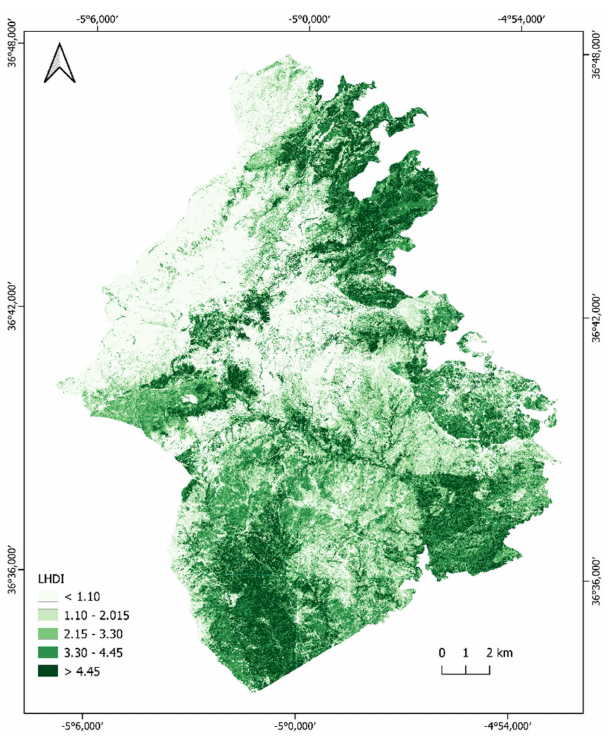
Figure 5. LiDAR Height Diversity Index (LHDI) of forest types in Sierra de las Nieves National Park (M á laga, southern Spain). Table 3. Biomass, LiDAR Height Diversity Index (LHDI), and Fuel Desiccation Index (IDM) of